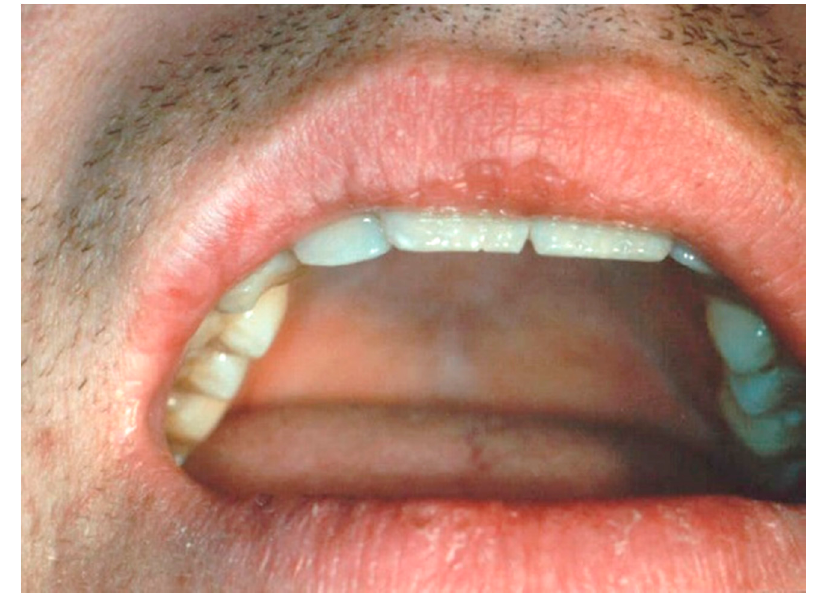
Figure 14. The aesthetic aspect at 6 months post operation. The vaporization was performed using a CO 2 laser.